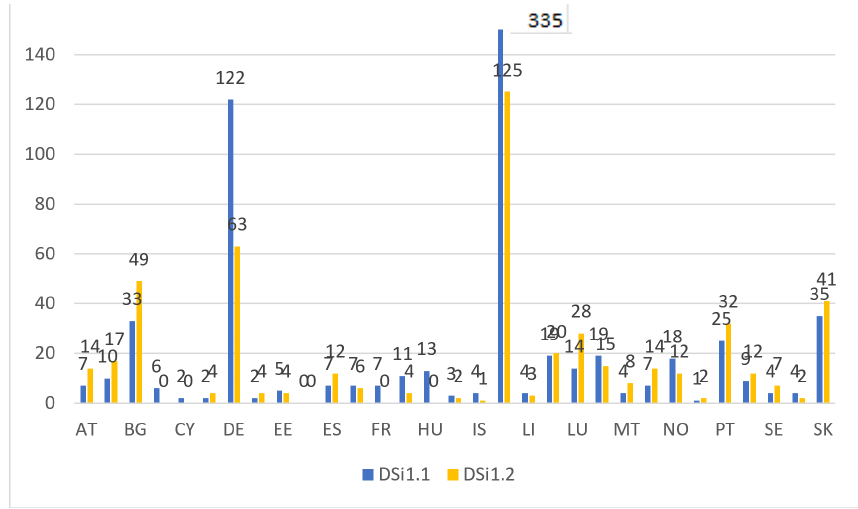
Figure 9. DSi1.1 and DSi1.2 indicators for the hydrography. The DSi1.4 and the DSi1.5 are the indicators of the number of spatial datasets that cover regional and national territory, respectively. For the hydrography theme, it was possible to extract these indicators directly from INSPIRE Geoportal. For better insight into all values on the chart, the ordinate axis was limited to 100, despite Italy having 270 DSi1.4 indicator value. The green bar indicates the DSi1.4 national coverage, and the blue bars are indicators of the DSi1.5 regional coverage with spatial datasets. As seen from the Figure 10, most of the countries significantly ’prevail’ the indicator of the national coverage, while only two countries with the biggest datasets generally available have the regional coverage indicator, the DSi1.5, significantly stronger than the national one.